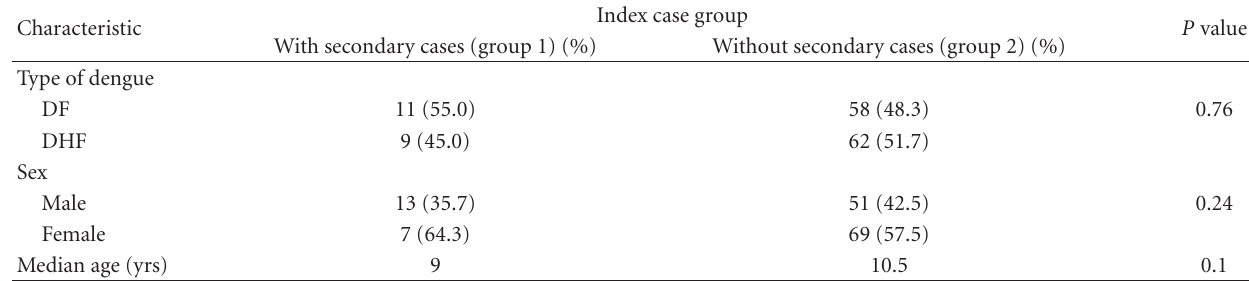
Table 2: General characteristics of DF/DHF cases classified by group of index cases.